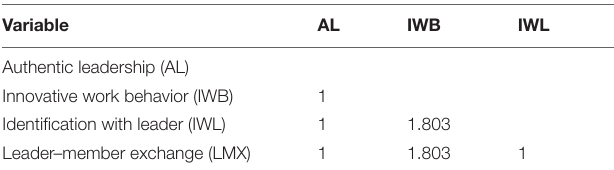
TABLE 4 | Variance inflation factor (VIF).